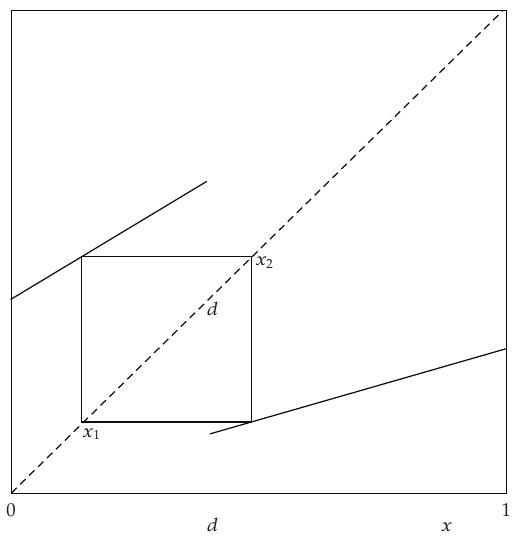
Figure 7: Discontinuous limiting map T 2 with m L (cid:7) 1 − δ A (cid:7) 0 . 6, m R (cid:7) 1 − δ B (cid:7) 0 . 3, d (cid:7) 0 . 4.